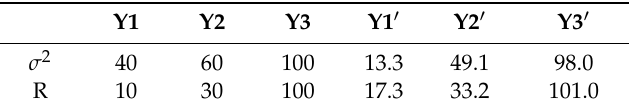
Table A1. Parameters for each component of the example.